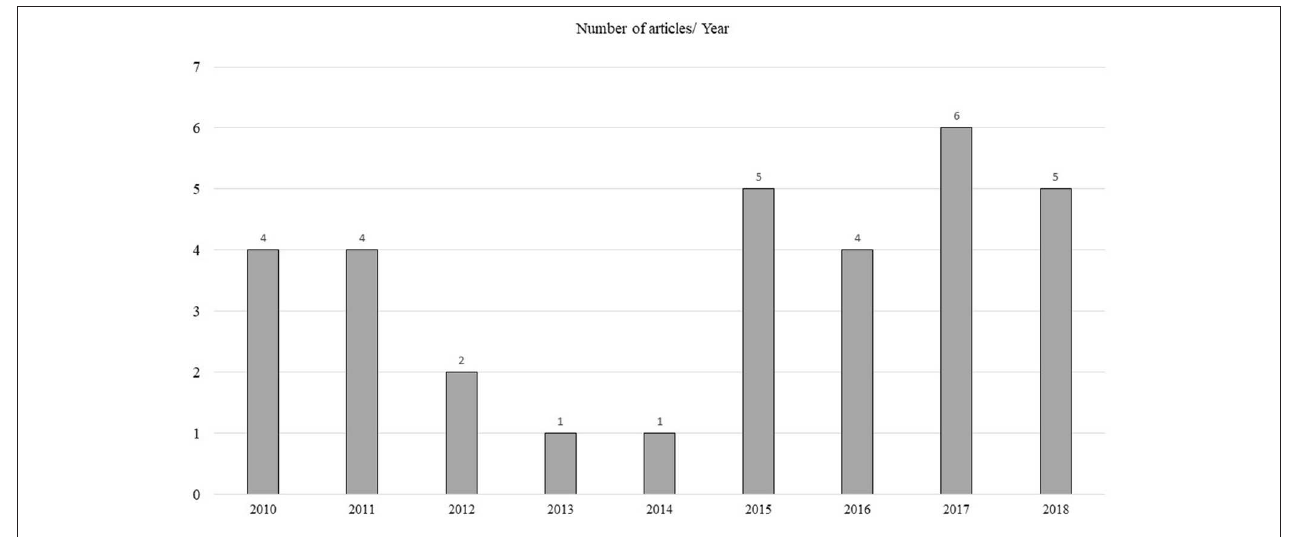
FIGURE 2 | Number of articles published per year.